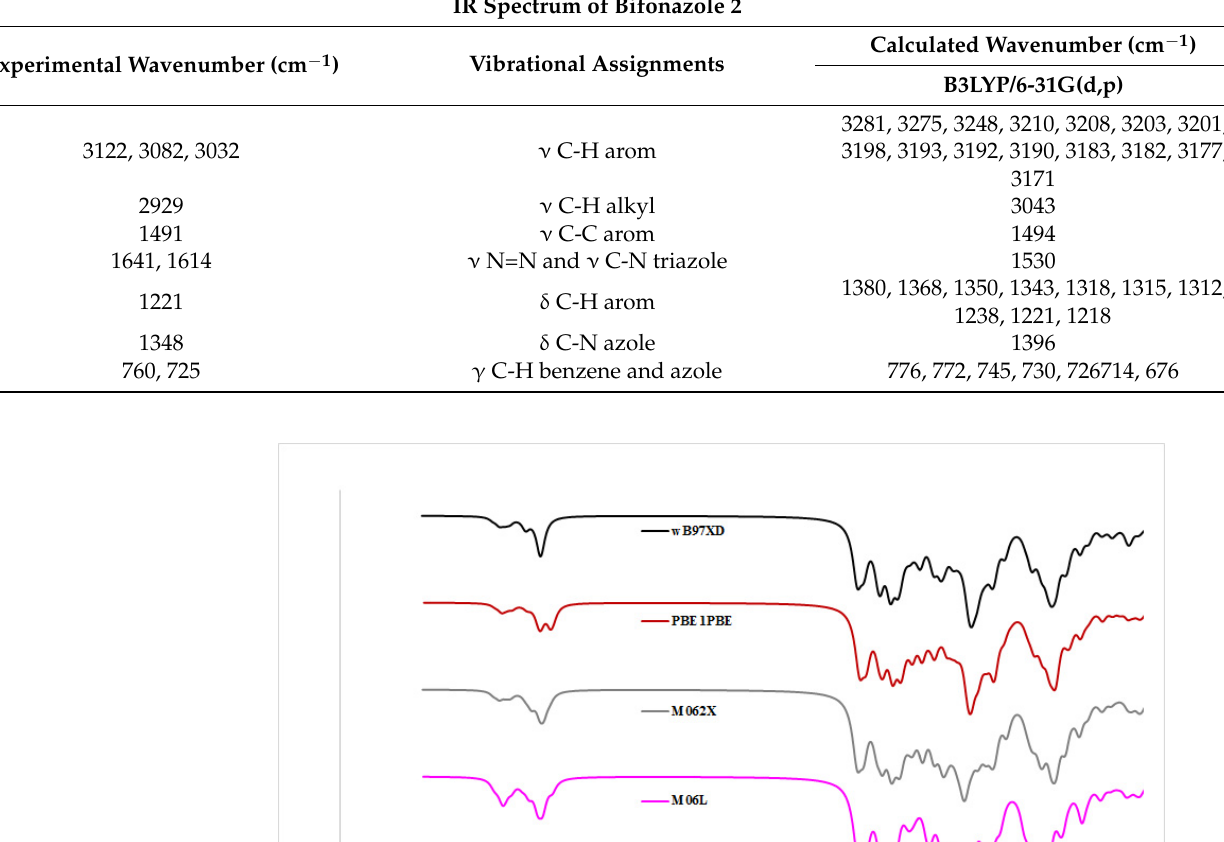
Table 4. IR spectrum of compound 2 ; B3LYP/6-31G(d,p)/gas level of theory; υ : stretching; δ : in-plane bending; γ : out-of-plane bending.